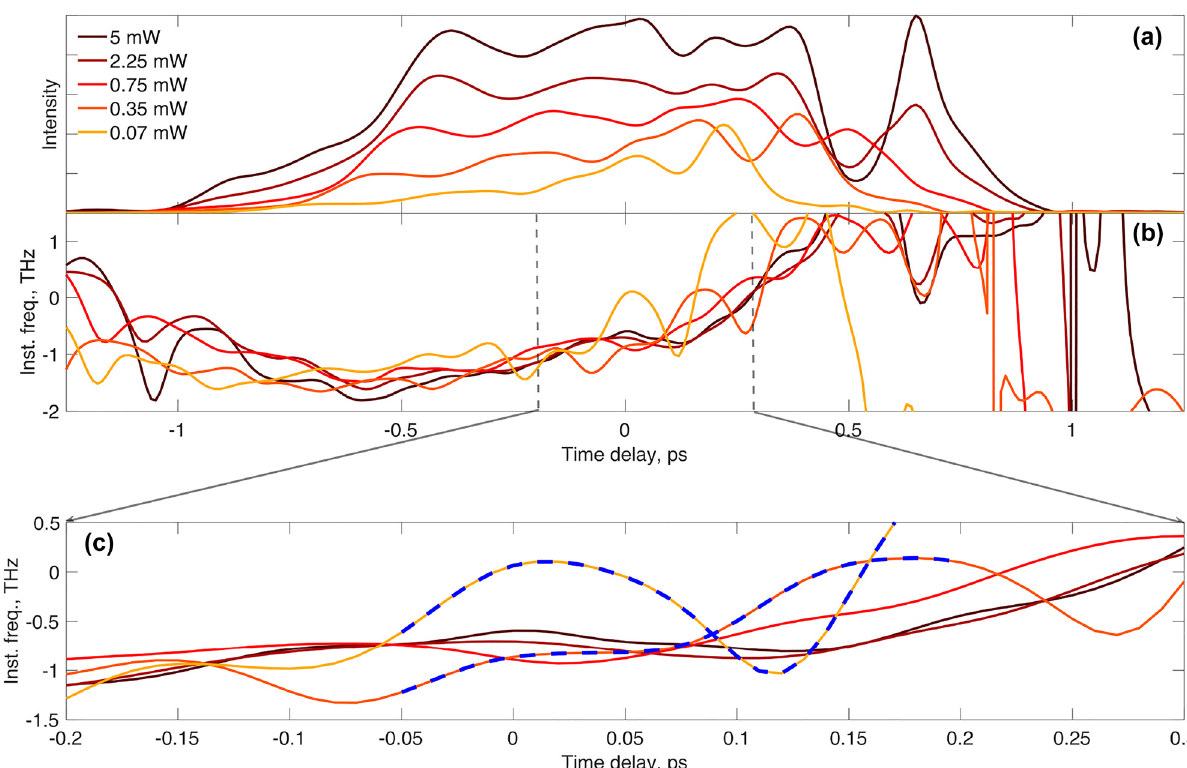
Figure 2: Experimental results of the temporal pulse profiles following the interaction with the TI-QDs for varies excitation pulse powers. (a) Normalized intensity profile, (b) and (c) instantaneous frequency profiles. The blue dashed line is shown for eye guidance. The TI-QD amplifier is biased to gain.